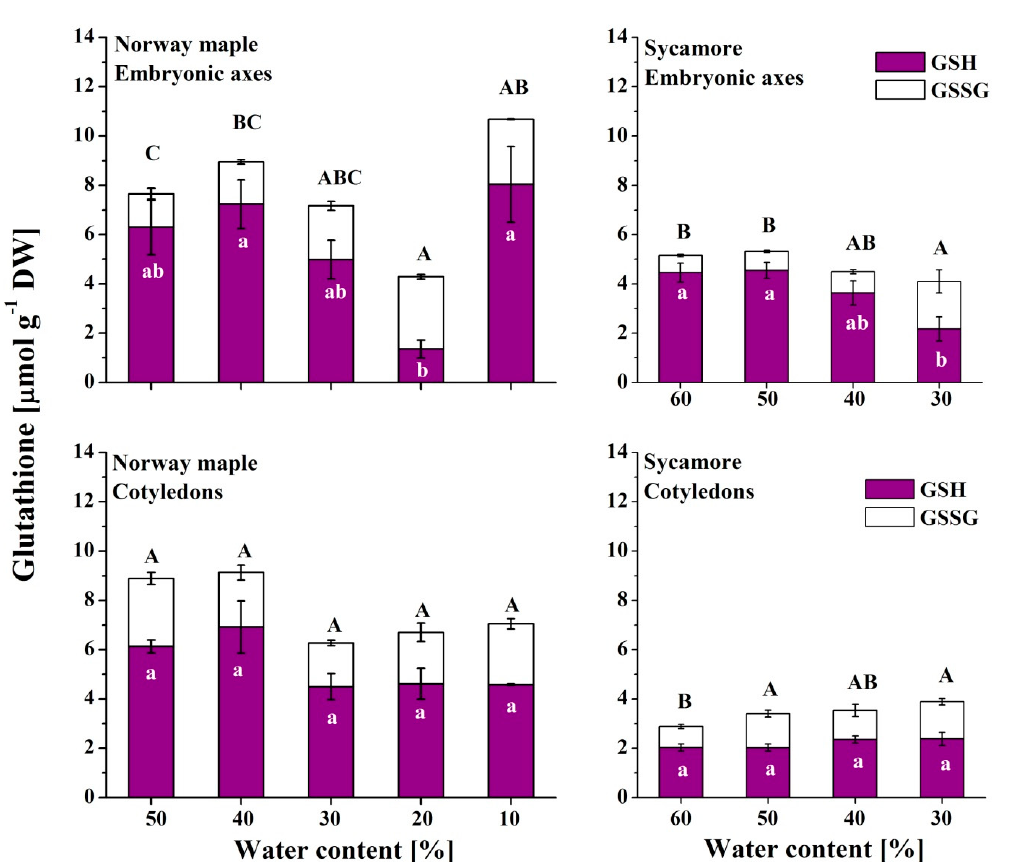
Figure 5. Levels of the reduced (GSH) and oxidized (GSSG) forms of glutathione measured in the embryonic axes and cotyledons of desiccated Norway maple and dehydrated sycamore seeds. The data are the means of three independent replicates ± the STDs. The same letters indicate groups that are not significantly different according to Tukey’s test. The capital letters refer to GSSG.